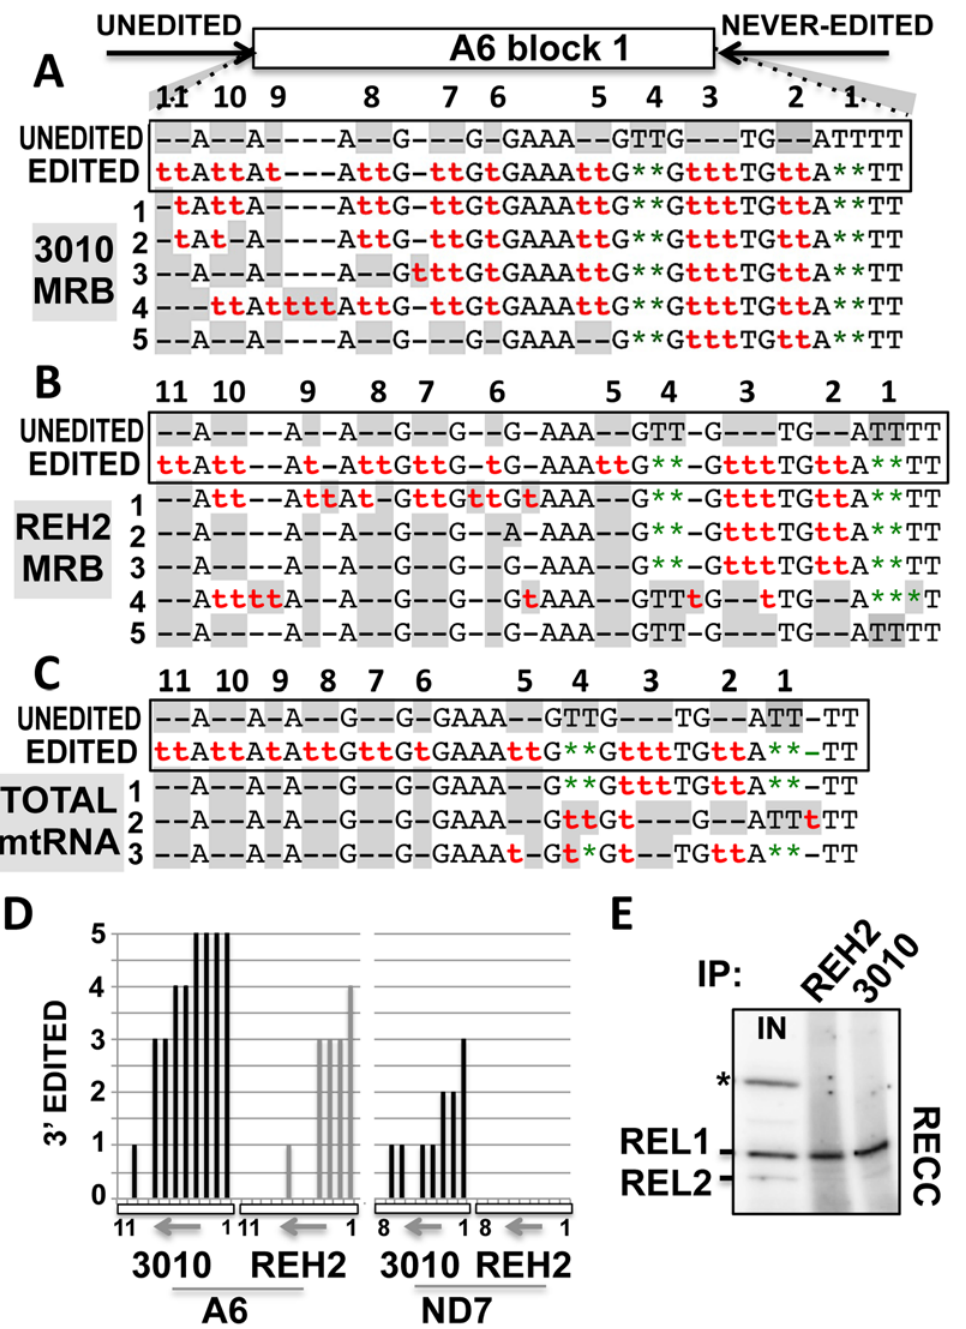
Fig 2. Efficient editing at block 1 in mRNAs bound to 3010-MRB. Block 1 sequence of a few mA6 transcripts amplified from (A) 3010 and (B) REH2 IPs or (C) total mtRNA from the mitochondrial extract loaded in the IPs. PCR primers (arrows) target 5 ’ unedited and 3 ’ never-edited sequence. The sequences in a box show sites 1-to-11 either unedited (gray) or fully edited with insertions ‘ t ‘ and deletions ‘ $ ’ . In clones 1-to-5, misediting (in number or site) is also shown in gray. (D) Number of correctly edited sites in the randomly selected clones of mRNAs A6 and ND7 (11 and 8 sites, respectively) purified from the IPs in panels A and B above and S1 Fig. Each bar is one site. The 3 ’ -5 ’ direction of editing (arrow) in block 1 (box) is indicated. (E) Radioactive autoadenylation of ligases REL1 and 2 in the RECC enzyme detected in REH2 and 3010 IPs. An asterisk marks a contaminant cytosolic ligase in mitochondrial extract input (IN). Pre- charged REL2 with endogenous ATP is poorly radiolabeled